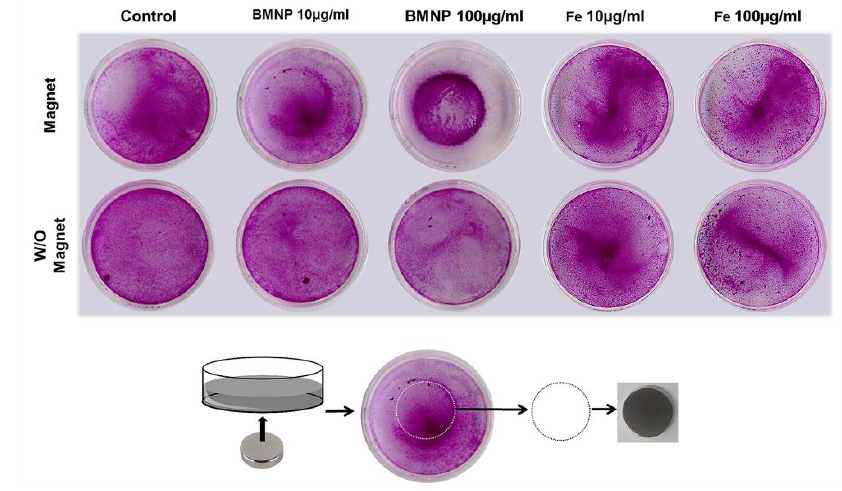
Figure 7. Magnetic migration assay. Representative image of colon cancer cells (HCT15) exposed to different concentrations of BMNPs and Fe and stained with SRB. Migration of the cells after treatments was evaluated in the presence or absence of a magnet. Schematic image represents how the circumference of the magnet (discontinuous line) corresponds with the cell clustering seen in the previous image.